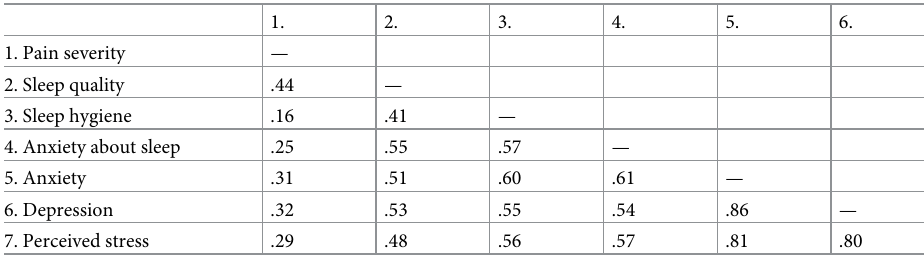
Table 2. Pearson correlations between variables used in the structural equation